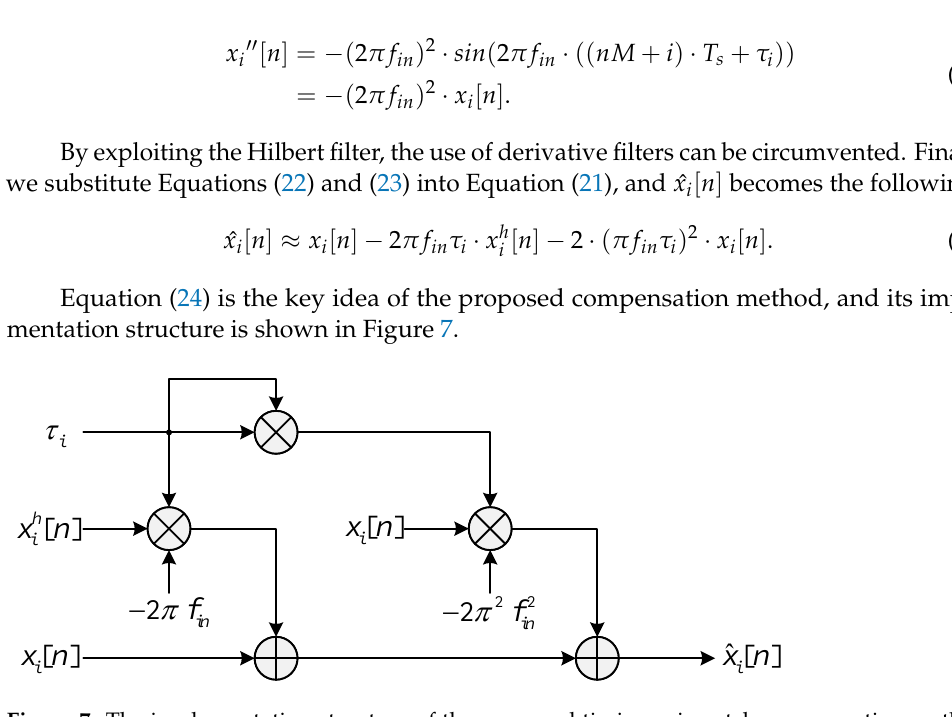
Figure 7. The implementation structure of the proposed timing-mismatch compensation method based on second-order Taylor series